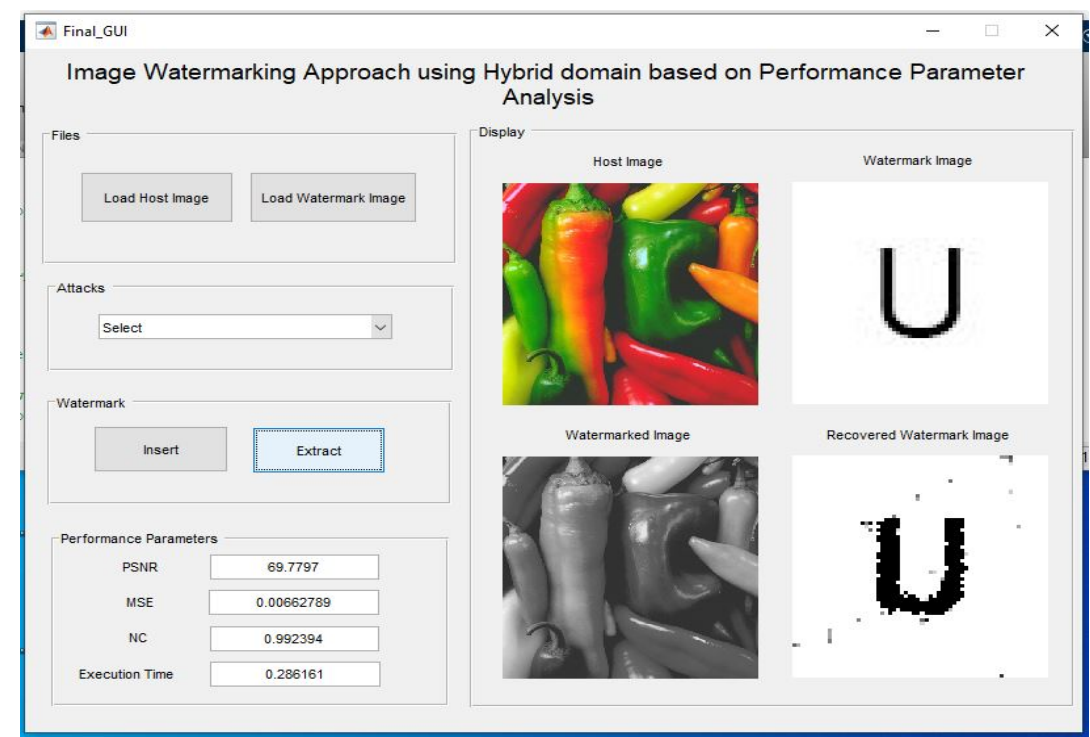
Figure 9. Embedding and extraction using the proposed method for a host image of size 512 × 512 and watermark of size 64 × 64.